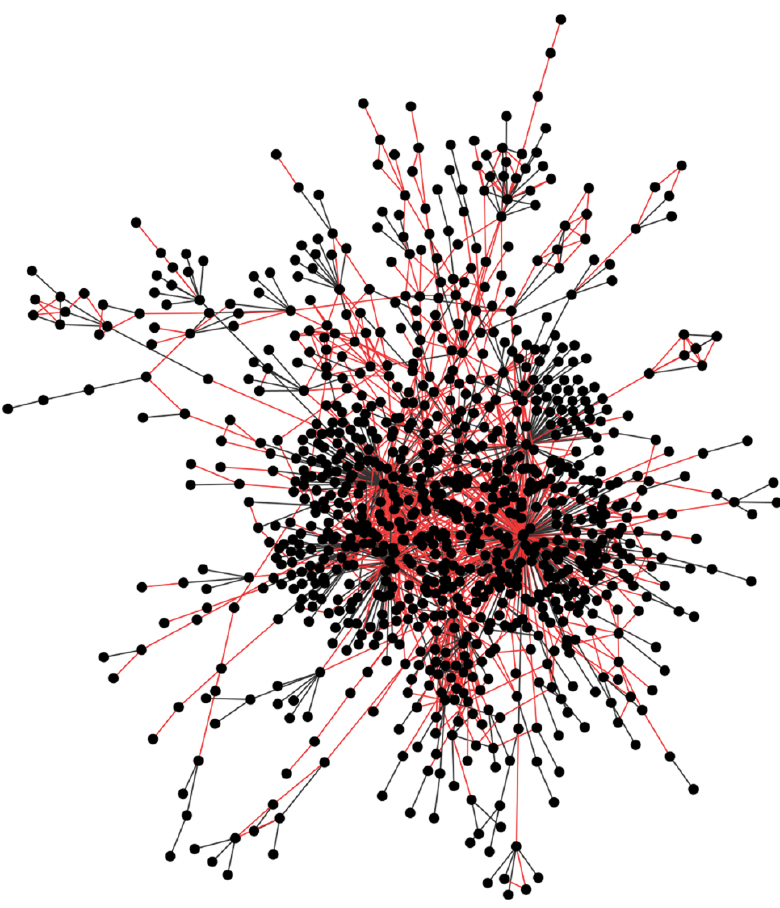
Figure 3: Example of common subgraph between three PPI networks computed by CytoMCS. Fully conserved edges are colored black while edges with one exception are colored red. Leaf nodes connected by exception edges have been fil-